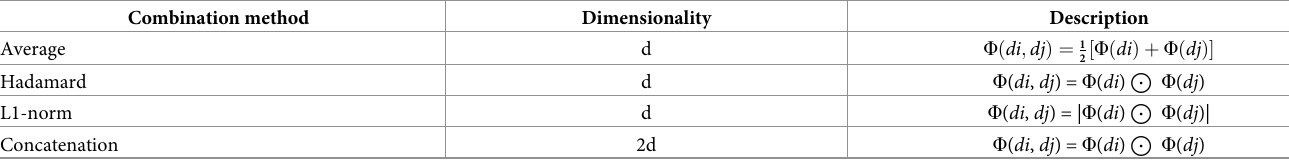
Table 2. Four different combinations of drug